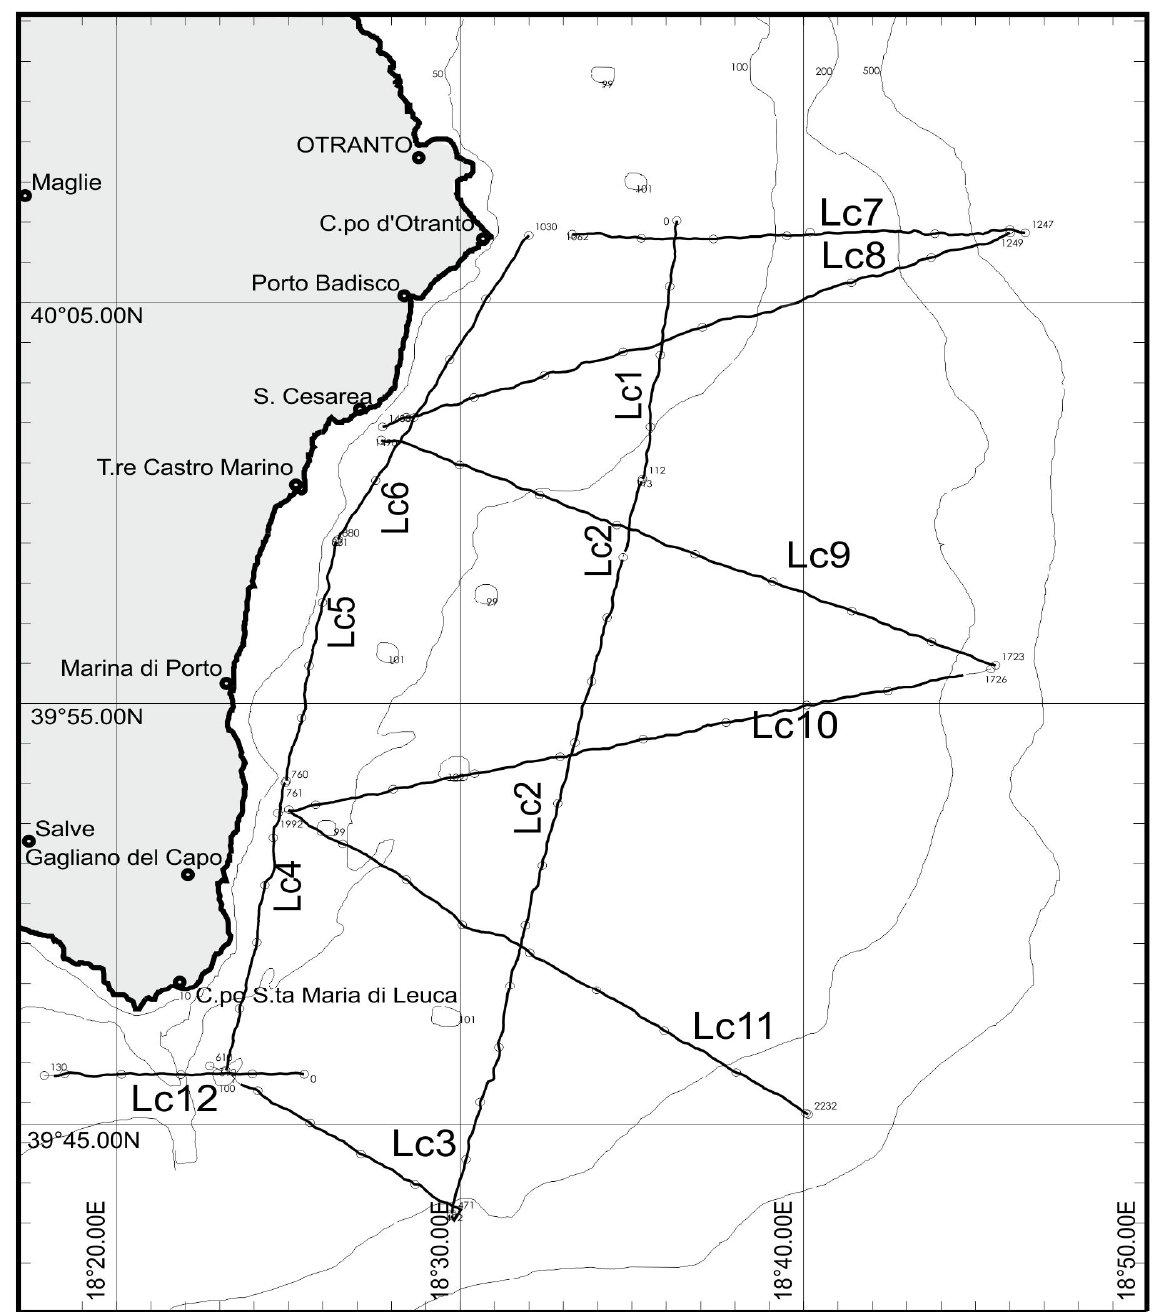
Figure 2. Navigation map showing the location of high-resolution seismic reflection profiles (Sparker 1 kJ); modified after [9].